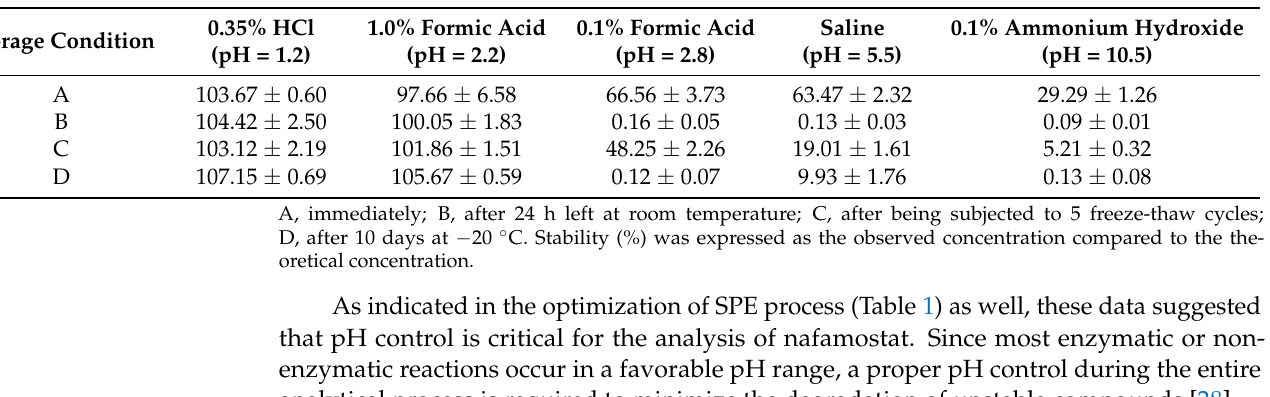
Table 2. Effects of pH on the stability (%) of nafamostat 160 ng/mL in the plasma under different conditions (mean ± SD, n =